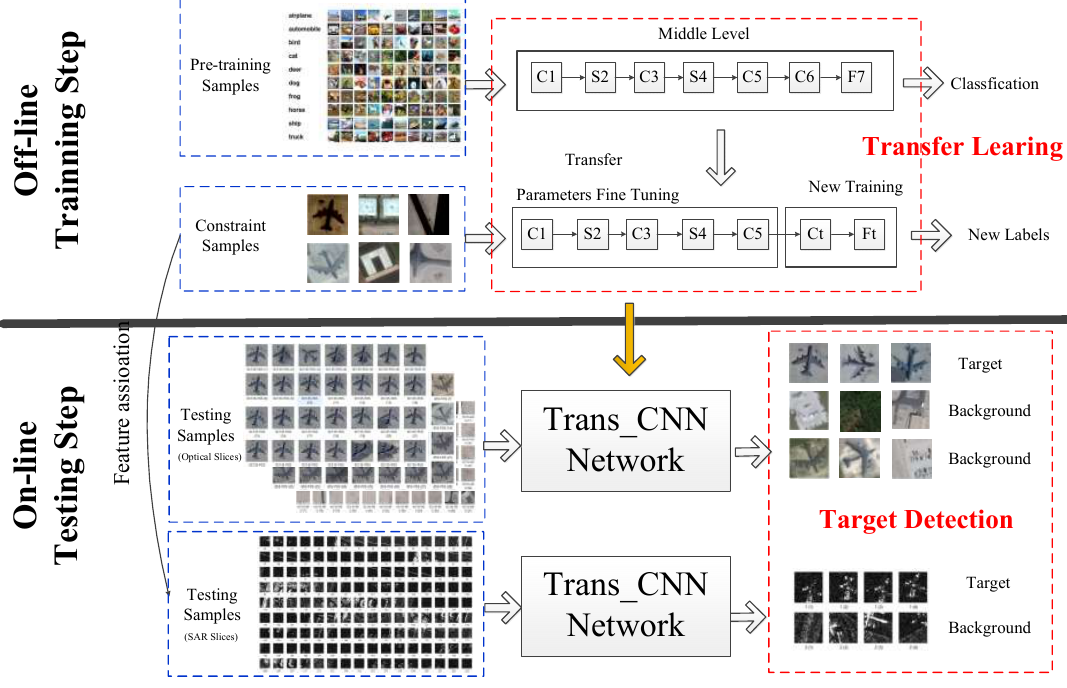
Figure 1. Algorithm